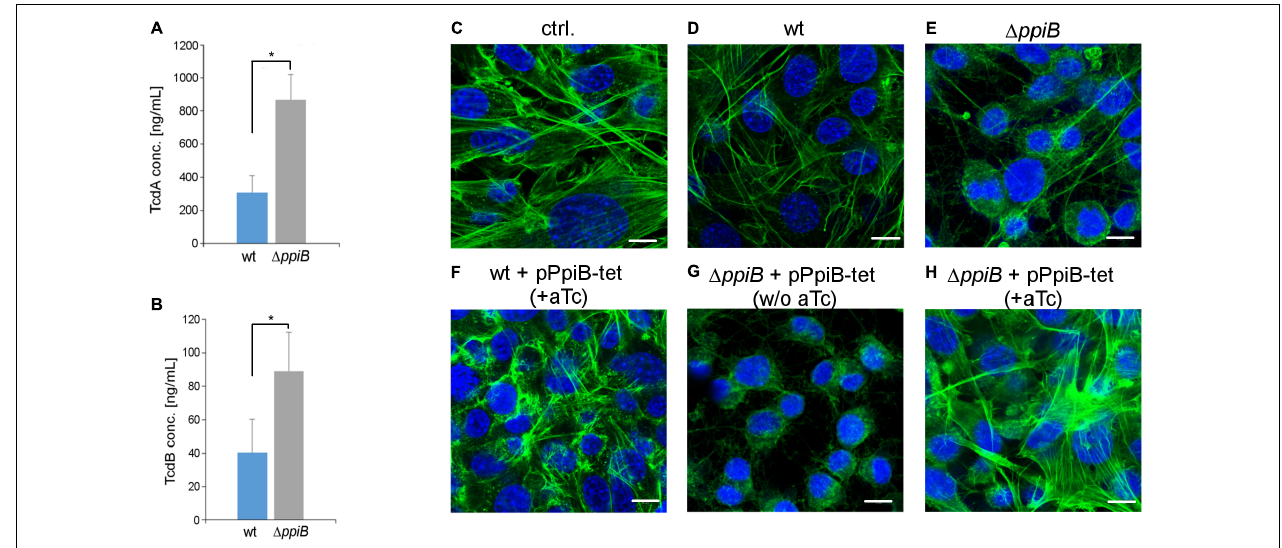
FIGURE 8 | Deletion of ppiB leads to higher toxin titres and cytotoxicity. (A) TcdA and (B) TcdB concentrations were measured by ELISA in 48 h old culture supernatants. Both toxins accumulated to significantly higher titres in culture supernatants in the isogenic (cid:49) ppiB mutant. Shown are means ± SD of three independent experiments performed in duplicate. Statistical significance was calculated by unpaired t- Test ( ∗ p ≤ 0.05). (C–H) PpiB influences the cytotoxic activity in the culture supernatant. (C) In untreated control NIH-3T3 cells the actin cytoskeleton is organized in stressfibers as it is typical for epithelial cells. (D) Cell-free supernatants from 24 h old wild type cultures that were diluted to 0.1% (vol/vol) in cell culture medium have visually no detrimental effect on the actin cytoskeleton. (E) Supernatants of the (cid:49) ppiB mutant cause disintegration and rounding up of the cells at the same dilution. (F) Overexpression of ppiB by the addition of 400 ng/mL anhydrotetracycline (aTc) in a tetracycline-inducible system has no detrimental effect on the cells in the wild type background. (G) The complemented strain exerts comparable cytotoxic activity as the (cid:49) ppiB mutant in the absence of aTc. (H) Overexpression of ppiB by the addition of aTc reduces the cytotoxic effect in the (cid:49) ppiB background to wild type levels. Shown are representative views of two separate experiments performed in triplicates. Actin cytoskeleton was stained green with Alexa488-coupled phalloidin, while nuclear DNA was stained blue with DAPI. Scale bars correspond to 10 µ